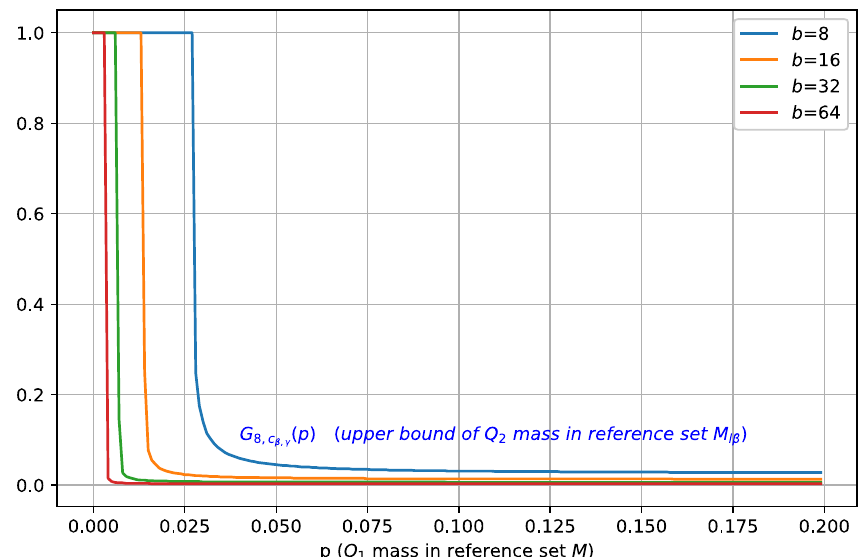
( p , l ) , i.e., the upper bound on s = Q ( M ) , plotted as a function of Figure 5. Illustration of G b , c ( ) Q M  s , plotted as a function of p  , i.e., the upper bound on ( , ) l 2 l · β Figure 5. Illustration of β , γ l 2  b c the mass p = Q 1 ( M ) (for c β , γ = 0.95, and different values of b ). For a fixed p , as the batch size is , ,  0.95 c increased, the maximal mass of Q 2 contained in M l · β decreases.  , and different values of b ). For a fixed p , as the batch size is ( ) Q M  p (for the mass ,  1 Q contained in M decreases. increased, the maximal mass of 2 l  In Section 3.2, we show that a topological constraint on a ( Q i , Q j ) pair would lead to probability mass concentration and separation. To impose this constraint, we propose a function that is used to construct the filtration, and then we compute the 0-dimensional persistent diagram and construct the loss item to regularize the internal representation. collection of n sub-batches, i.e., B = ( B 1 , . . . , B n ), as in [22]. Each sub-batch consists of b samples from the same class, and thus the resulting mini-batch B contains n * b